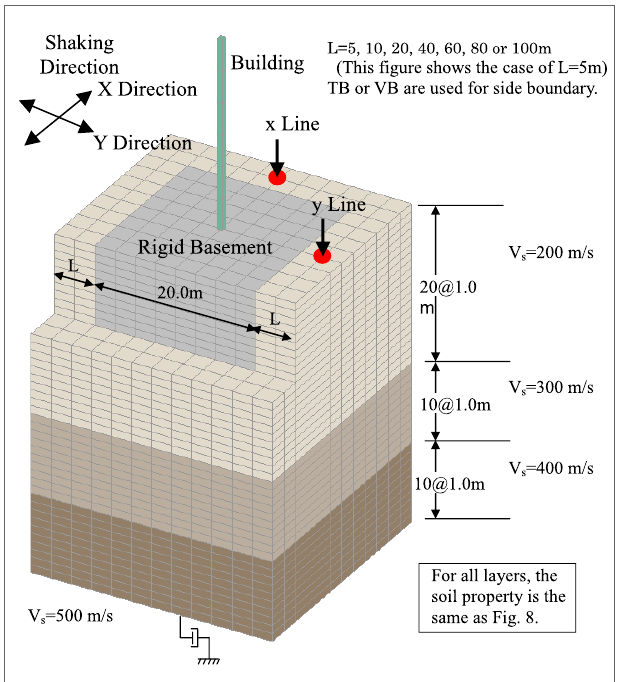
FigUre 12 | analysis model for seismic response